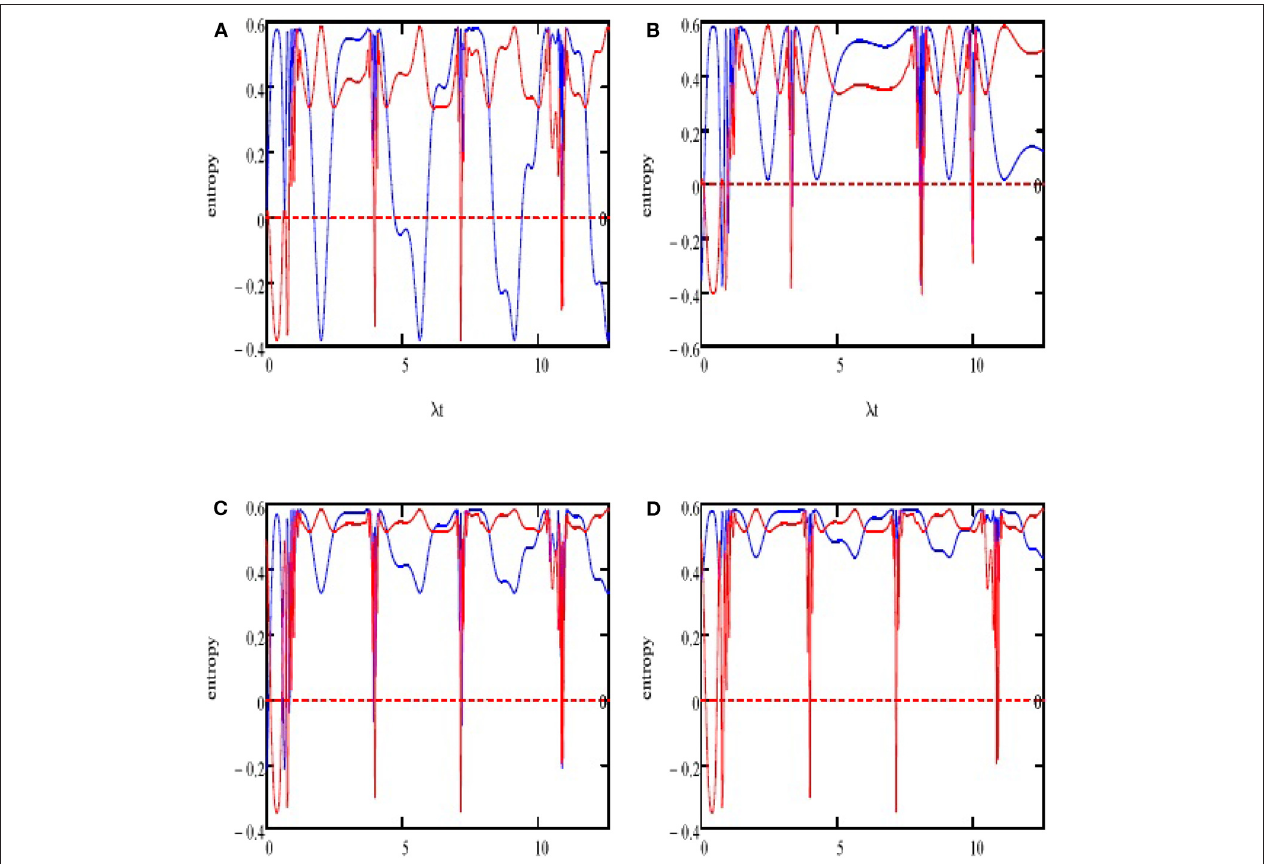
FIGURE 3 | (A–D) Variation of the entropy squeezing components E x ( t ) (blue curve) and E y ( t ) (red curve) of classical entropy for with the same parameters and conditions as in Figure 1